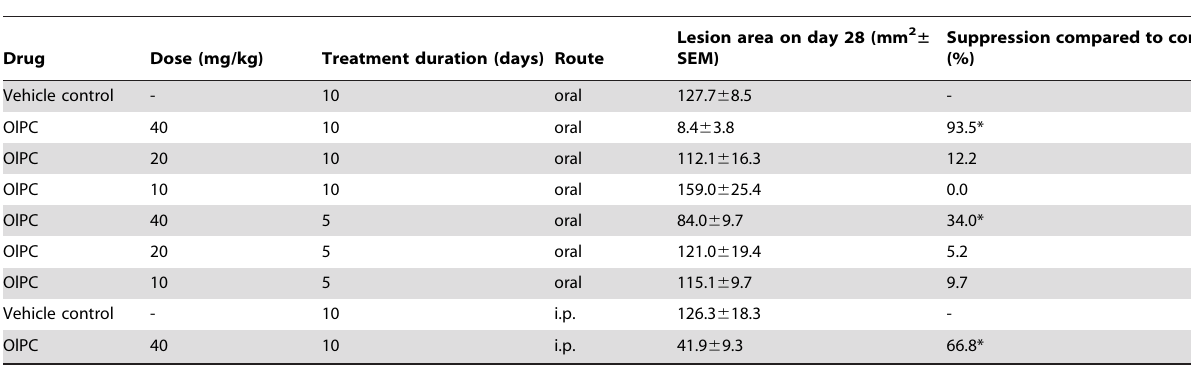
Table 1. Dose-response efficacy of OlPC in the mouse L. major lesion cure model (MLL).